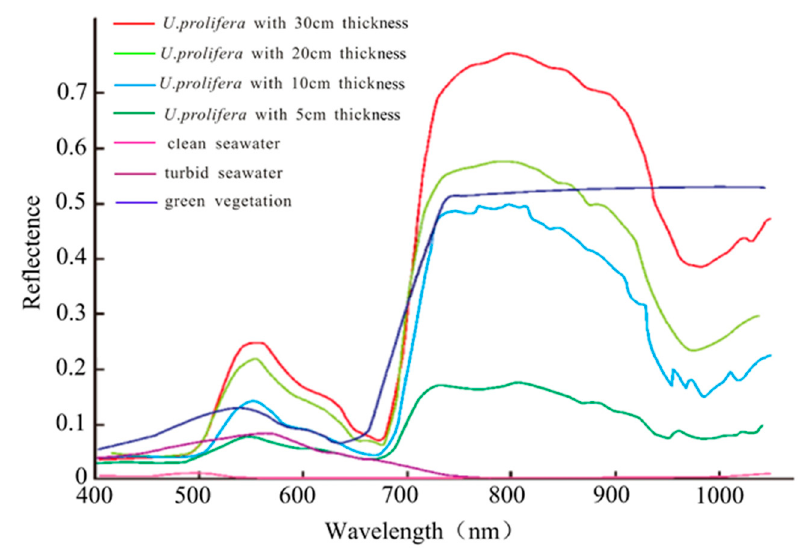
Figure 2. Reflectance spectra of the U. prolifera and seawater measured in situ.